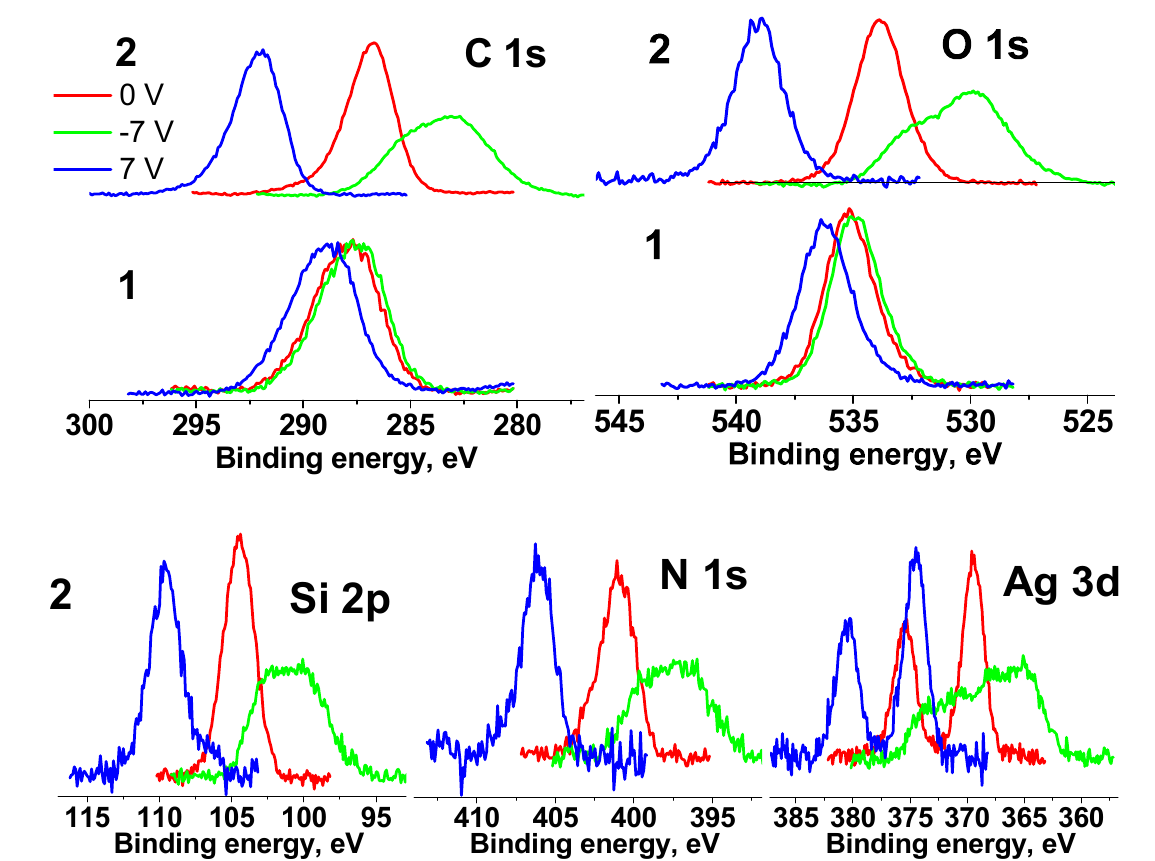
Figure 12. XPS C 1s, O 1s, Si 2p, N 1s and Ag 3d spectra of the cotton ( 1 ) and Ag NPs/HBPAPES/cotton ( 2 ) samples measured at different U b , the spectra are normalized by an area under the